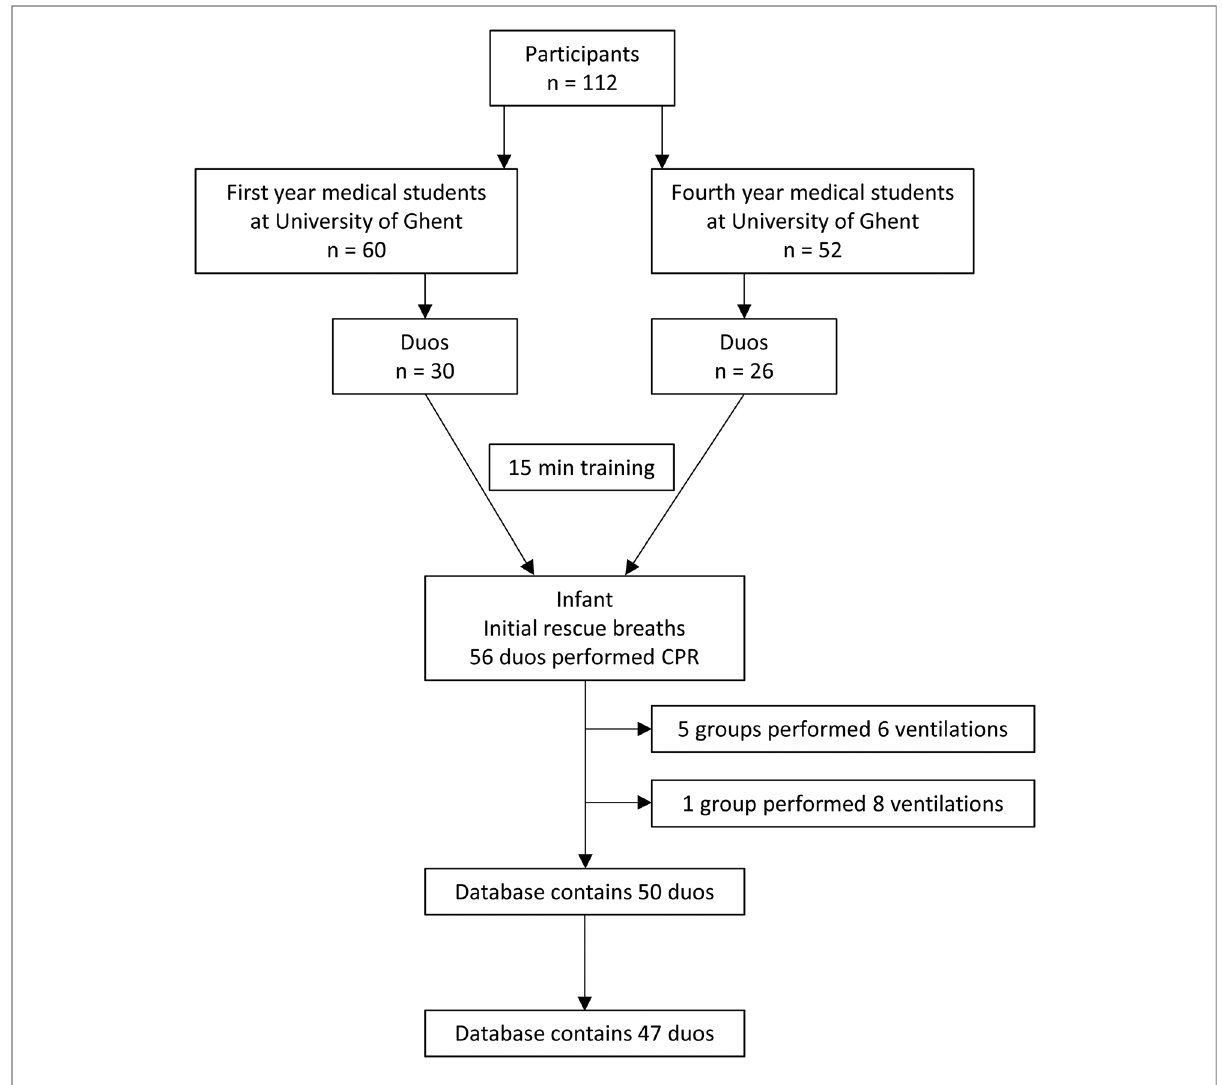
FIGURE 1 Flow of the participants in the study and during data cleaning.